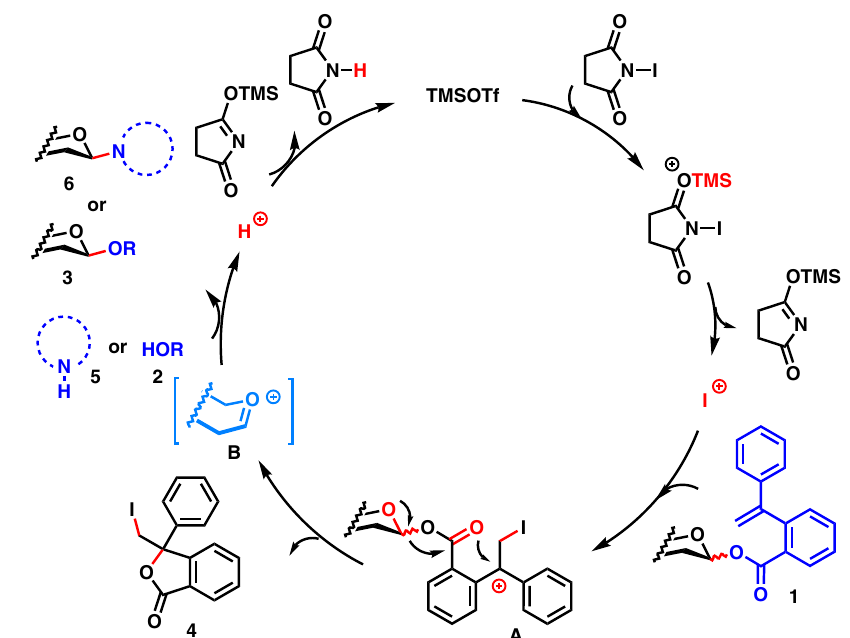
Fig. 6 A plausible mechanism of the glycosyl PVB glycosylation protocol. Highlighted in red are active species and chemical bonds cleaved and formed; highlighted in blue are leaving groups and nucleophilic acceptors and in light blue are oxocarbenium